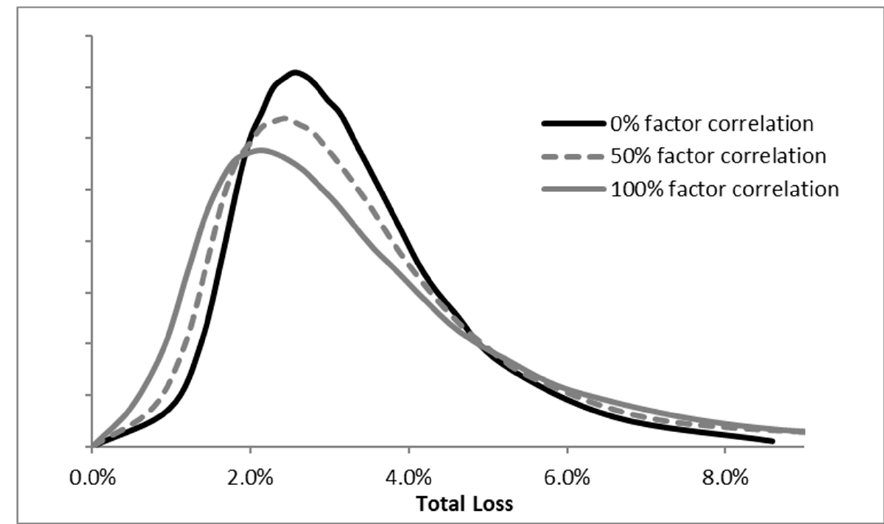
Figure 4. Overall loss distribution functions—Monte Carlo simulation results.